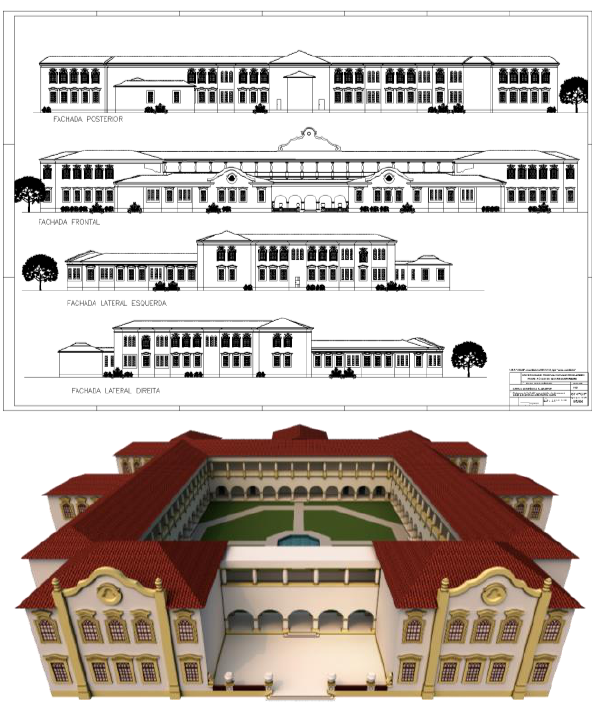
Figure 11. Above: CAD drawings of the Institute of Chemistry facades. Source: NGS / UFRRJ. Below: Three-dimensional modeling of the Institute of